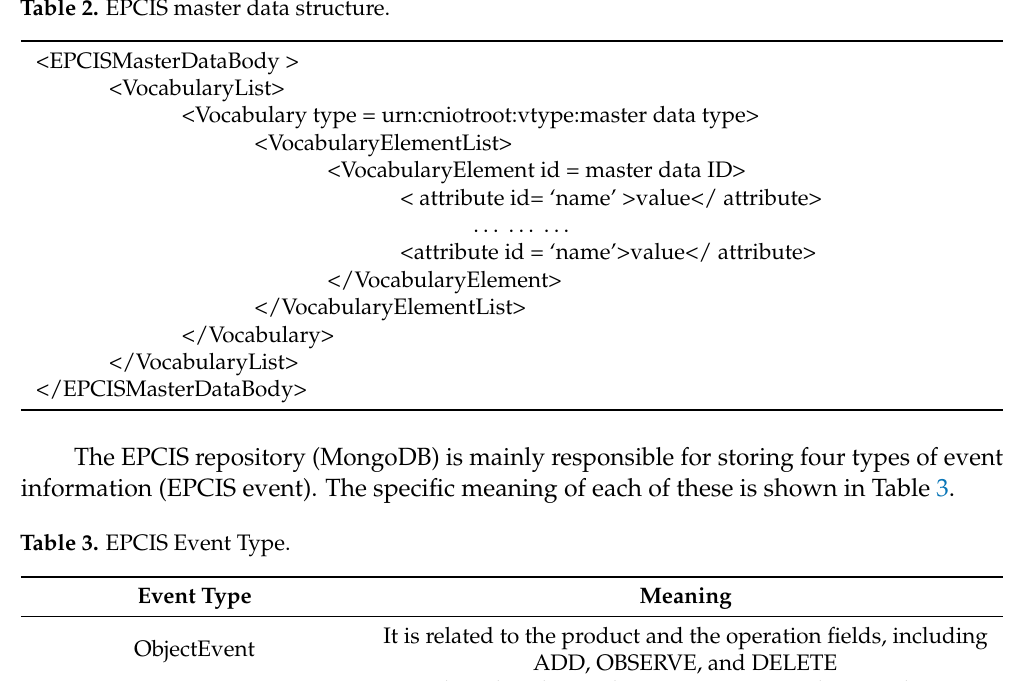
Table 3. EPCIS Event Type.